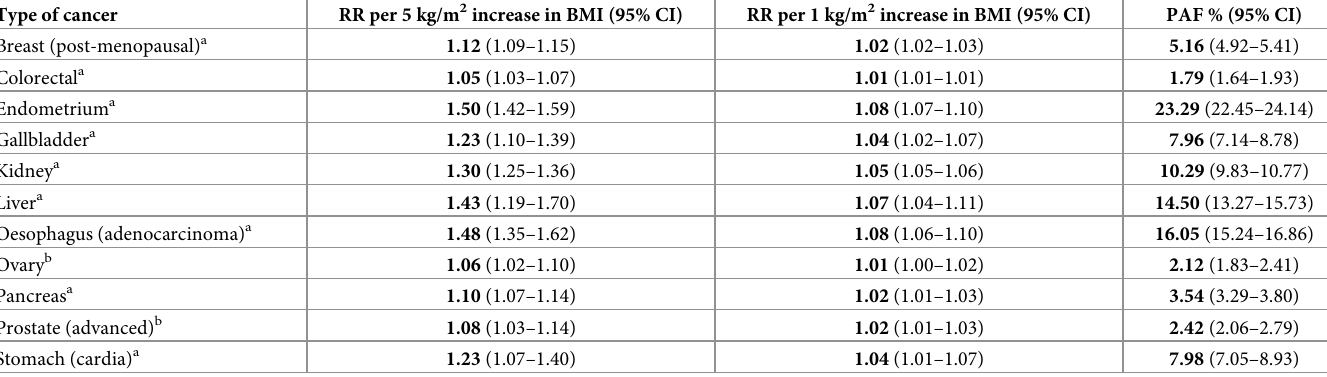
Table 1. Relative risk (RR) and population attributable fraction (PAF) of excess body weight-associated